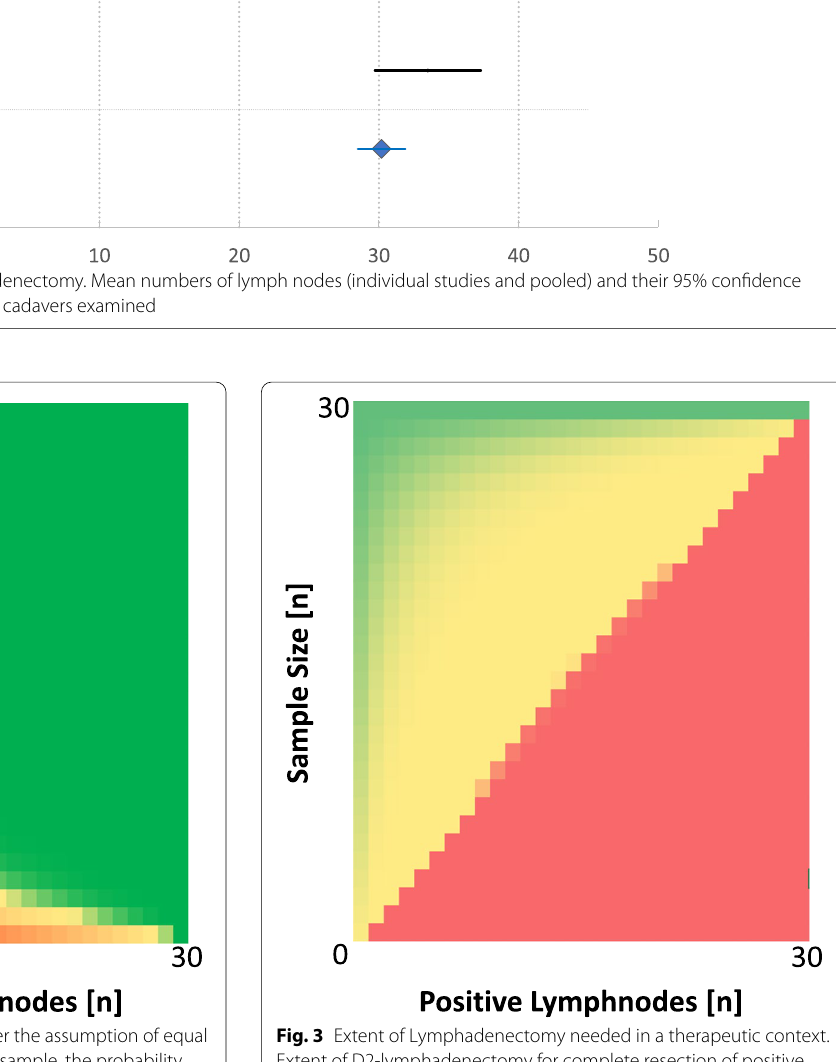
16 examined lymph nodes (Table 1, Fig. 4; p < 0.001). The proportions of patients with or without neoad- juvant or adjuvant chemotherapy were not differ- ent between nodal-negative groups with low and high numbers of lymph nodes.